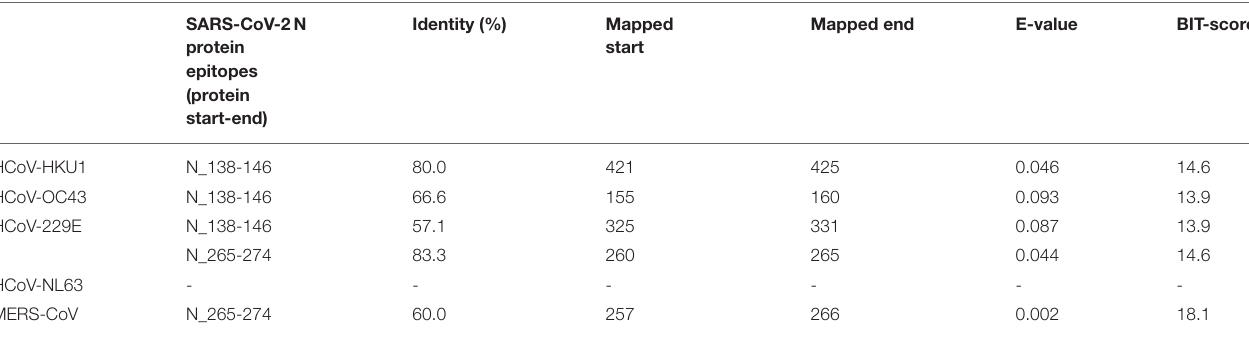
TABLE 5 | Sequence Identity of N proteins of human alpha- and beta-coronaviruses against SARS-CoV-2-derived T-cell epitopes (evaluated by blastp